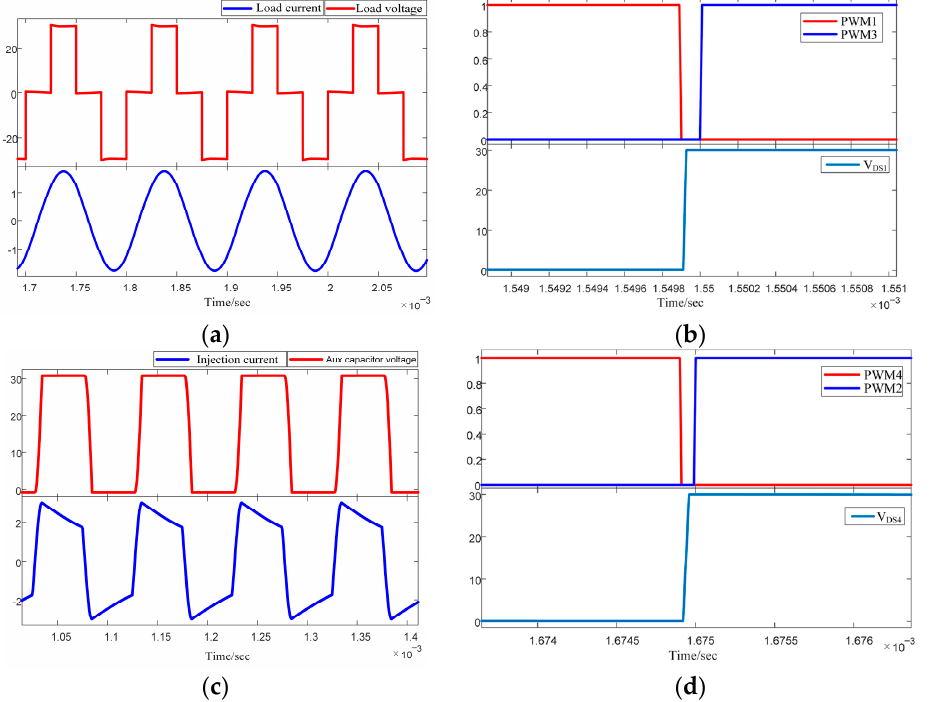
Figure 8. Main waveforms with auxiliary current source. ( a ) Load voltage and current waveform; ( b ) Q 1 Q 3 trigger signal and Q 1 drain-source voltage waveform; ( c ) Voltage waveform of the auxiliary capacitor and the auxiliary current source injection current waveform; ( d ) Q 2 Q 4 trigger signal and Q 4 drain-source voltage waveform.